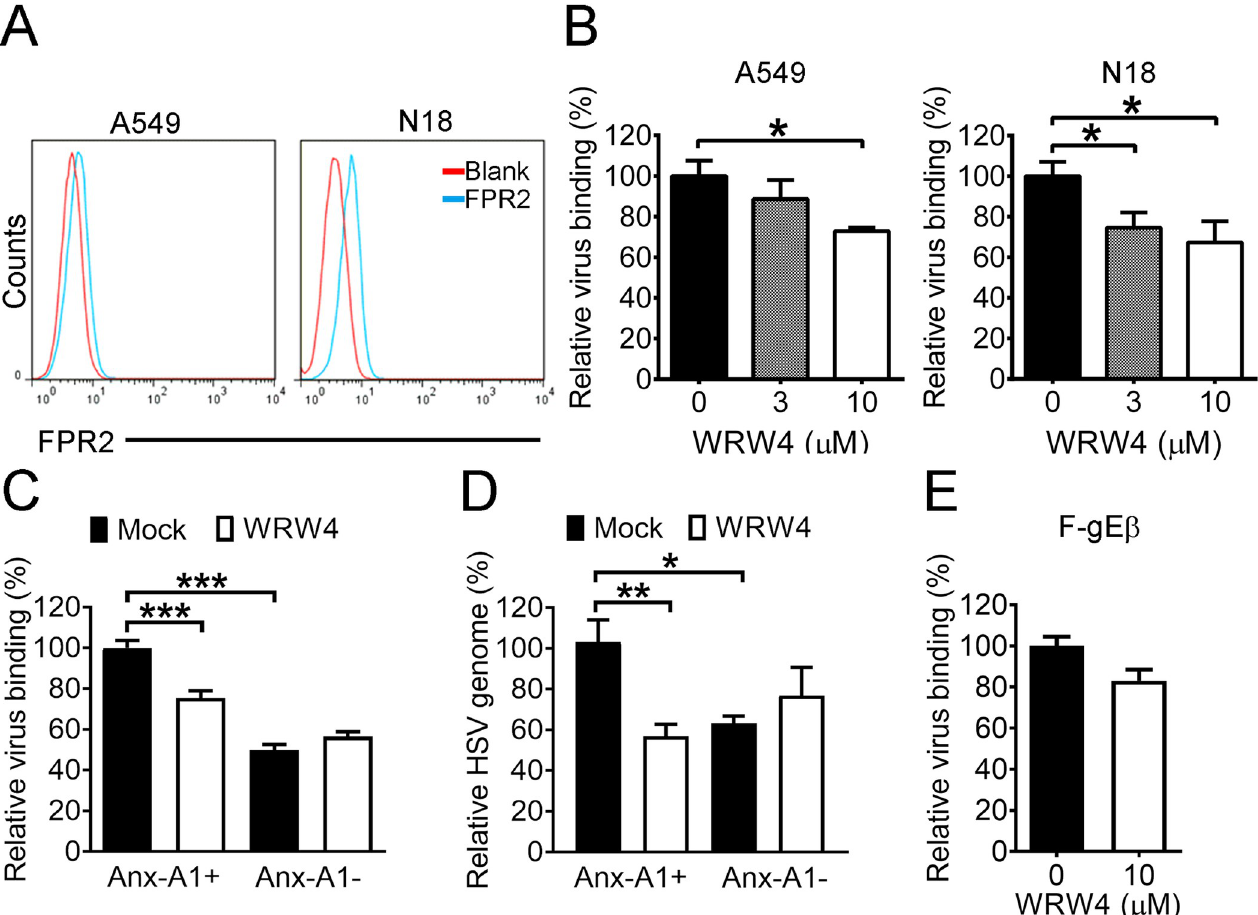
Fig 7. Blocking FPR2 reduces HSV-1 binding. ( A ) Representative histograms of FPR2 detected on the surface of the indicated cells are shown. ( B ) The levels of virus binding to the indicated cells treated with the indicated concentrations of WRW4 are shown. The levels of Anx-A1-positive (Anx-A1+) or Anx- A1-negative (Anx-A1-) HSV-1 binding to N18 treated without or with WRW4 (10 μ M) were determined by plaque assay ( C ) and real-time PCR ( D ). ( E ) The levels of strain F-gE β binding to N18 cells treated without or with WRW4 (10 μ M) are shown. Panels B and E were determined by plaque assay. The levels of Anx-A1+ virus binding to cells without WRW4 treatment were set as 100% in panels C and D, and the level of strain F-gE β binding to N18 cells treated without WRW4 was set as 100% in panel E. Data show the mean + SEM of > 4 samples per group. � P < 0.05, �� P < 0.01, and ��� P < 0.001.